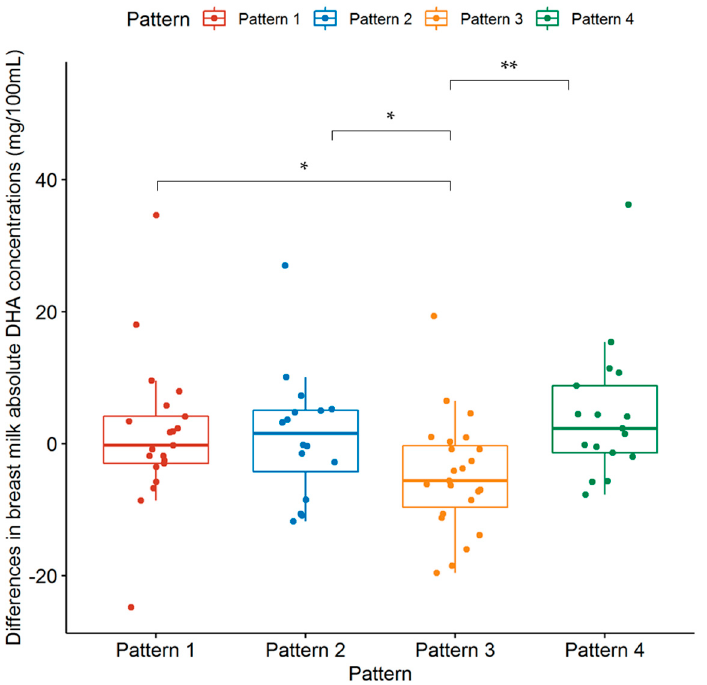
Figure 3. Changes in the absolute DHA concentrations of the breast milk with respect to dietary patterns in the supplement group. * p < 0.05, ** p <